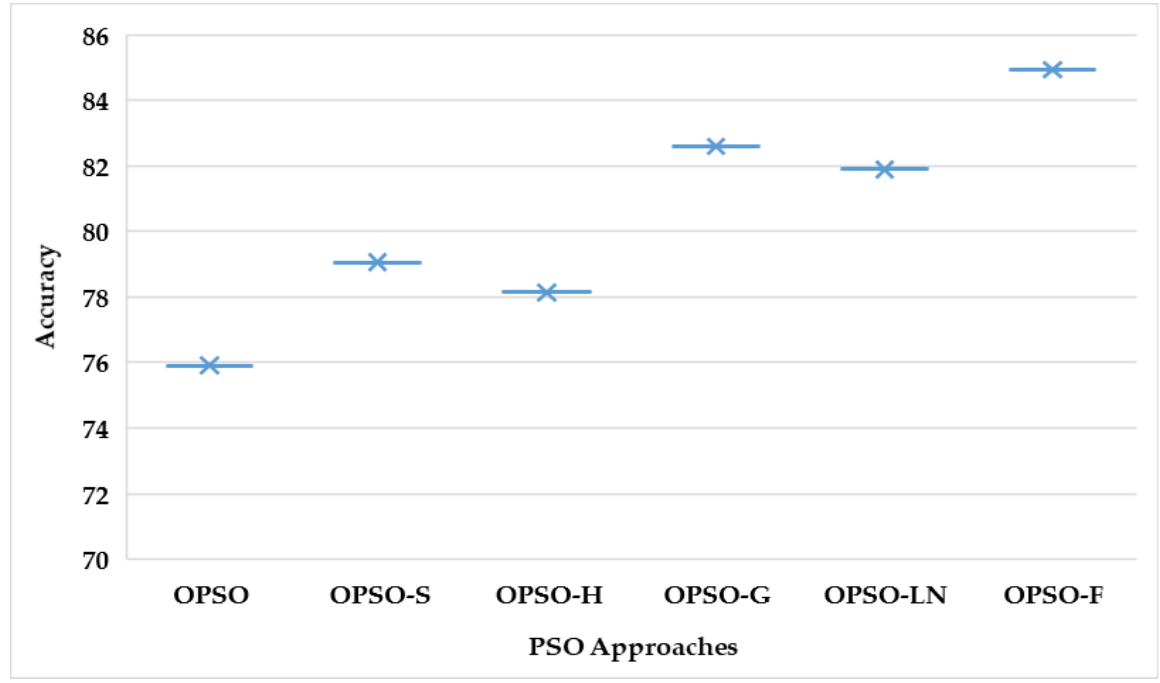
Figure 12. One-way ANOVA test on testing accuracy.